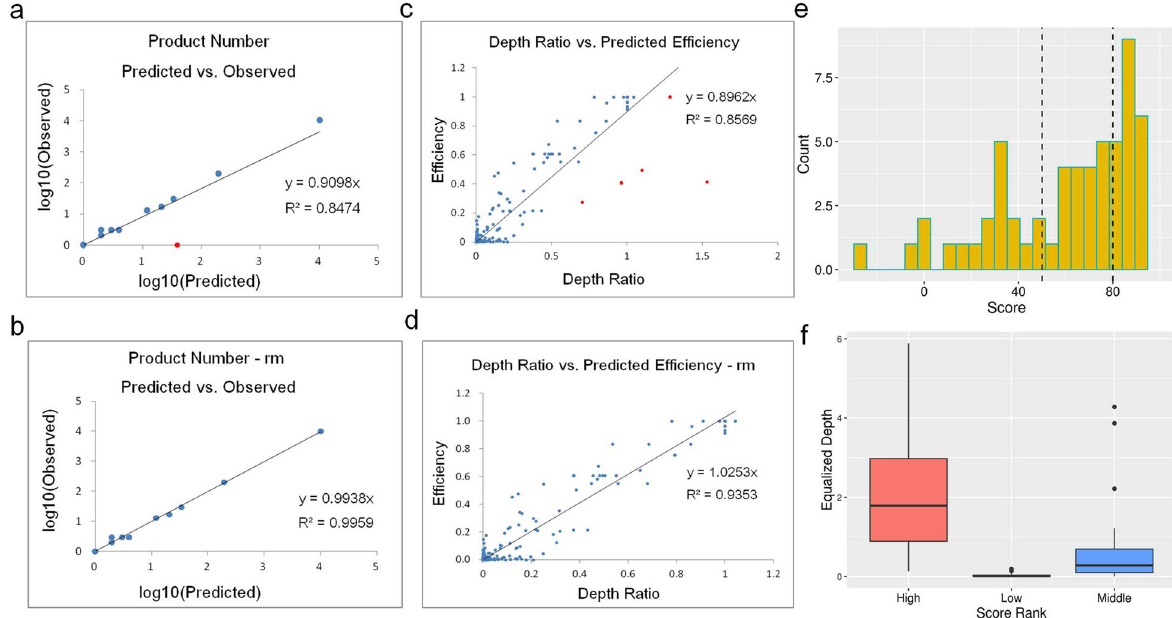
Figure 6. Experimental evaluation of specificity and score in PrimerScore2. ( a,b ) Comparison of observed vs. predicted product number of 12 low-specificity primers. R 2 (coefficient of determination) reaches 0.99 if an outlier (red point) is removed. ( c,d ) Linear correlation between observed depth ratio and predicted efficiency of all products of 11 low-specificity primers (Speci-6 was excluded for more than 10 k non-target products). The slope of the fitting line was from 0.896 to 1.025, and R 2 reached 0.94 when five outliers (red points) were removed. ( e ) Distribution of 57 primer scores. Primers with scores of more than 80 were considered to be high- scoring, those with scores lower than 50 were low scoring, and the rest were middle scoring. ( f ) Distribution of the equalized depth of high-scoring, low-scoring, and middle-scoring primers. The equalized depth is the ratio of depth to the